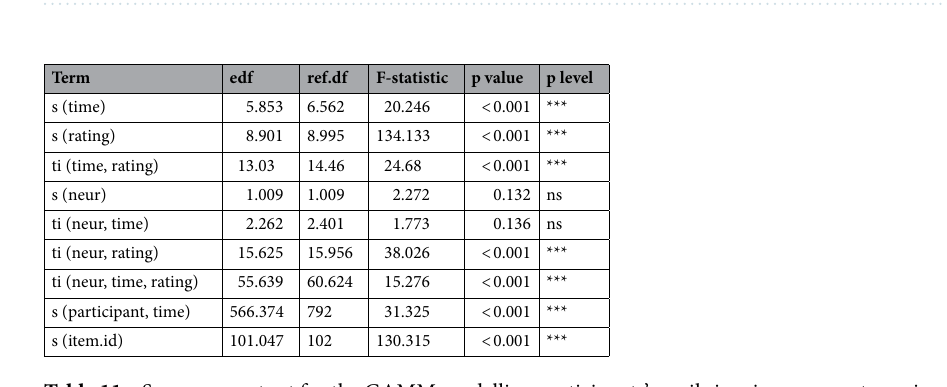
Table 11. Summary output for the GAMM modelling participants’ pupil sizes in response to socio-cultural violations and with their Neuroticism score as a